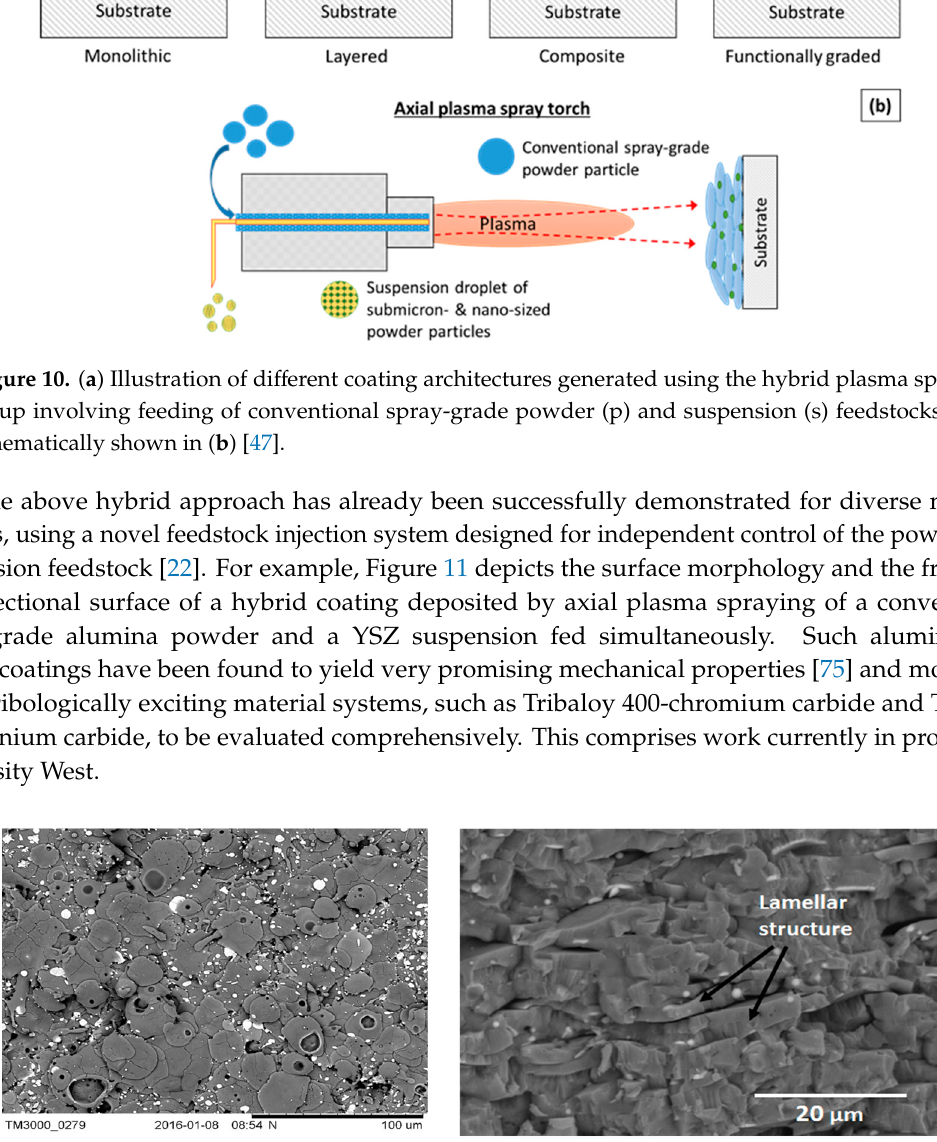
Figure 11. ( left ) Surface morphology of a typical alumina (powder)–YSZ (suspension composite coating showing multiscale structure [22] and ( right ) transverse fractured surface of the composite coating showing vertically aligned solidification feature in alumina splats with distributed YSZ (seen as the brighter phase in both micrographs) [21].